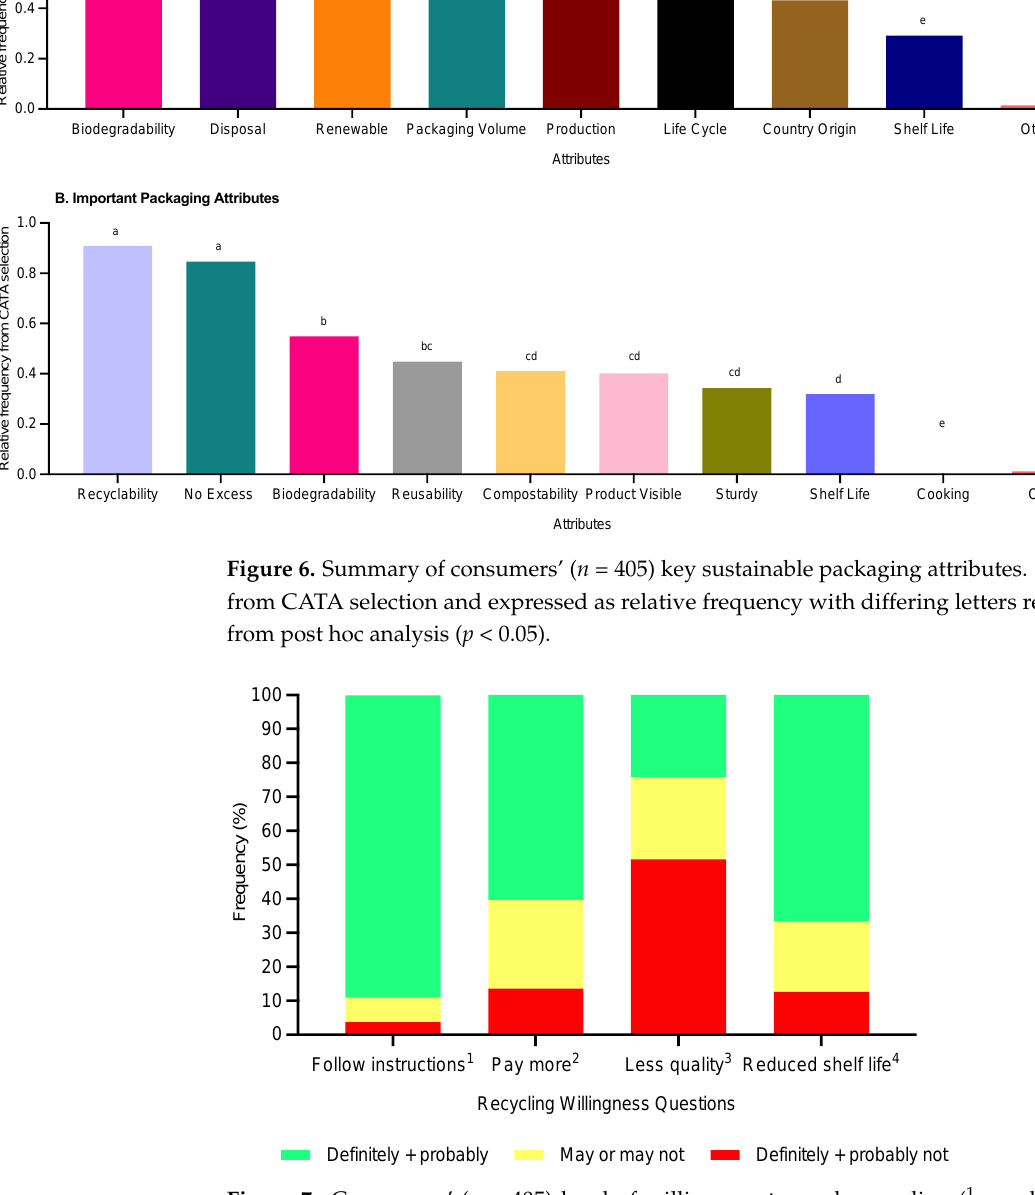
Figure 7. Consumers’ ( n = 405) level of willingness towards recycling ( 1 would you follow the recycling instructions on a food package? (Figure 1); 2 would you be willing to pay more for sustainable food packaging?; 3 would you be willing to have less quality for more sustainable food packaging?; and 4 would you be willing to have a reduction in shelf life for more sustainable food packaging?) from five-point category scales.